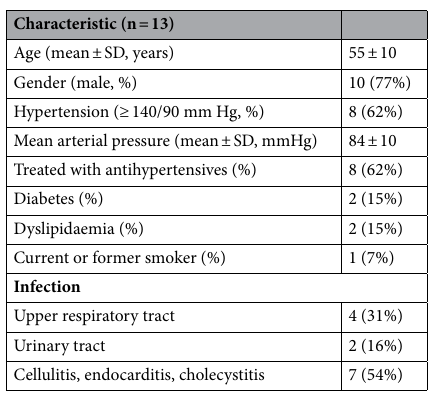
Table 4. Participant characteristics where initial and final CRP levels were both > 100 mg/L.